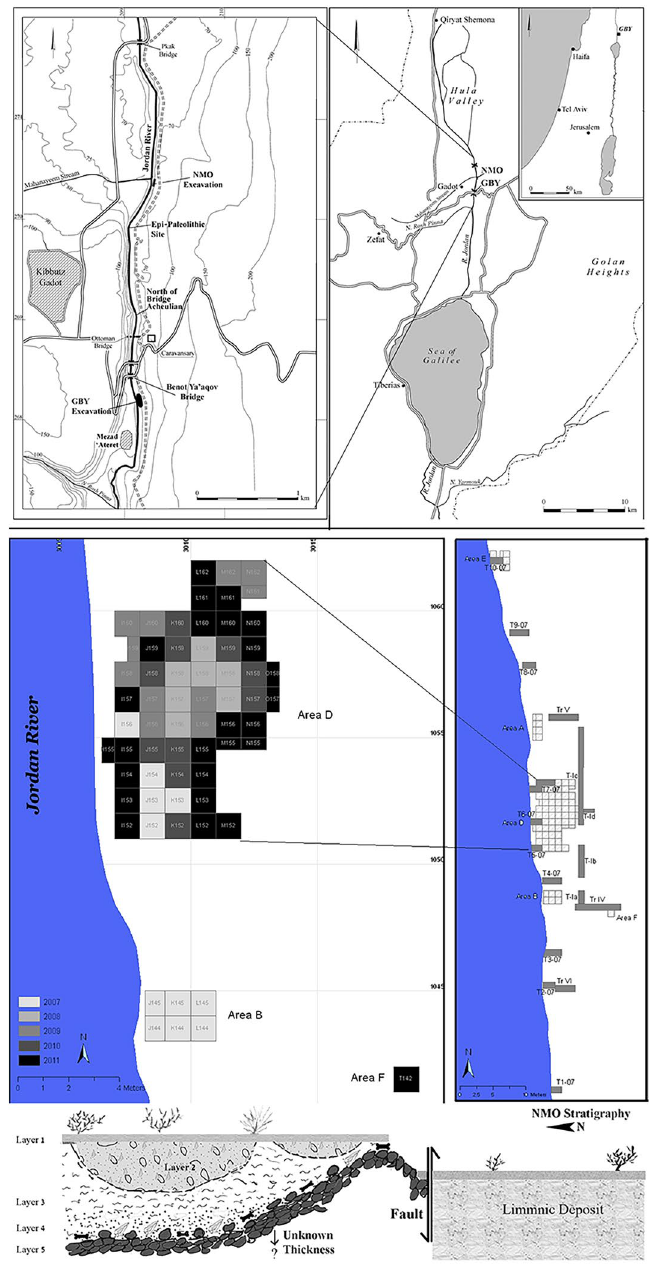
Figure 1. Location of the NMO site, excavation areas, excavated squares, and schematic representation of the